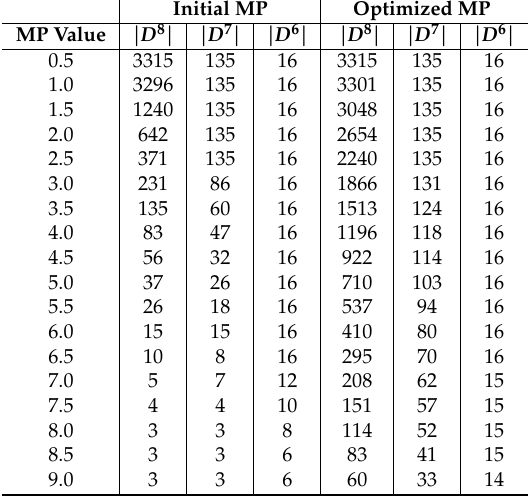
Table 2. The number of OTs for a given MP value in the original in [15] and the optimized OTs with our algorithm. The set D include all the elements in C which have a MP lesser or equal to the given MP